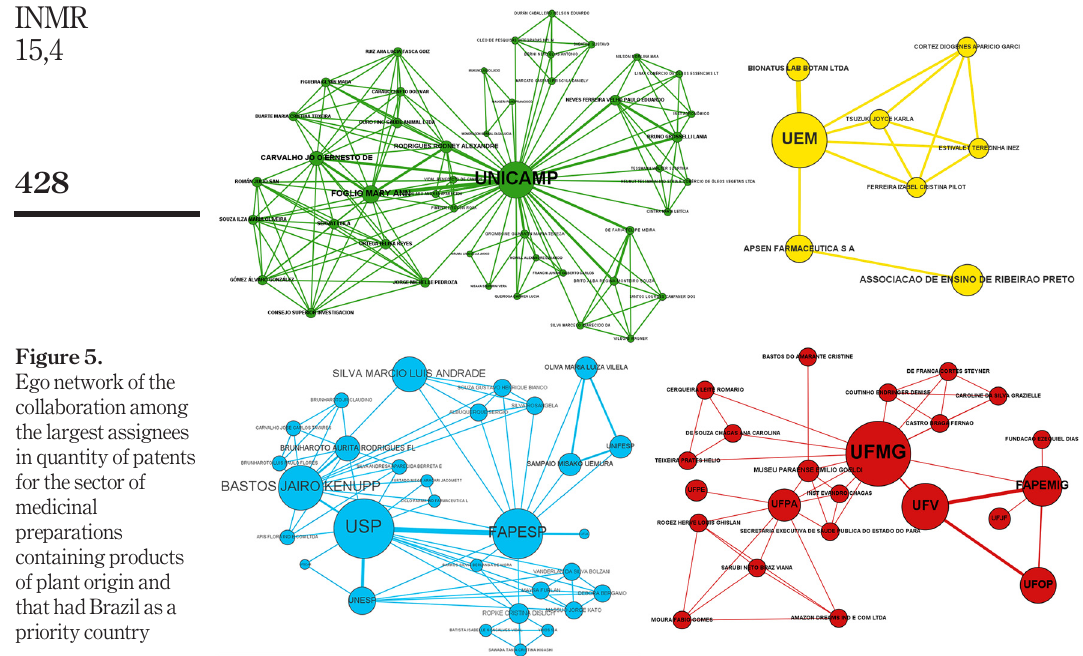
Figure 5. Ego network of